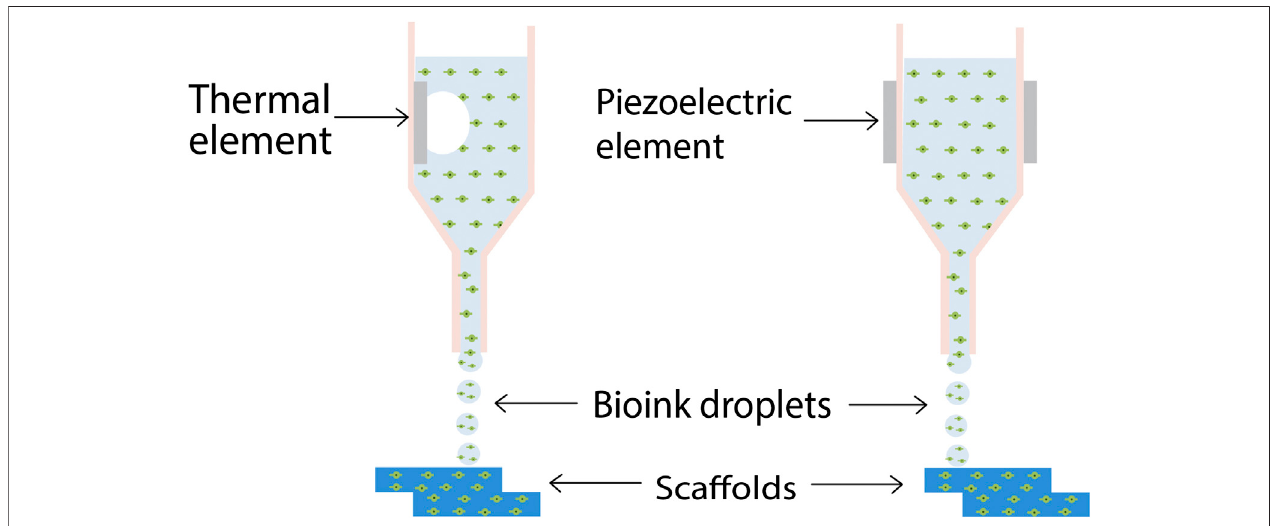
FIGURE 2 | Schematic diagram of inkjet 3D bioprinting. Thermal inkjet printing induces droplet formation by means of a heating element, while in piezoelectric ink- jet printing, a piezoelectric element induces the droplet nucleation (Ka ˇ carevi´c et al., 2018) (used from an open access journal).